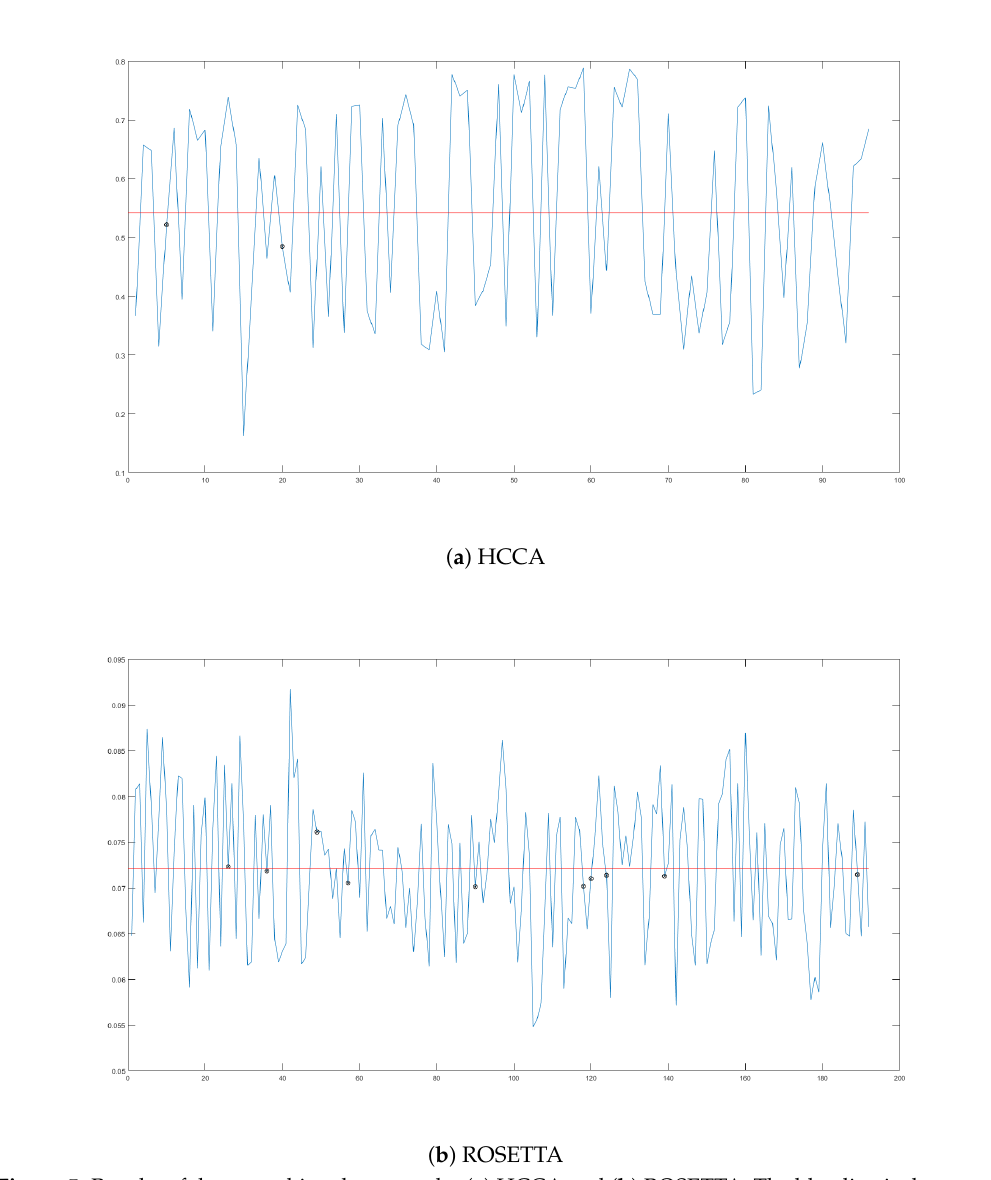
Figure 5. Results of the secret bit value guess by ( a ) HCCA and ( b ) ROSETTA. The blue line is the secret bit value guess and the horizontal red line is the threshold value for the secret bit value discrimination; points with a black circle indicate where the attack